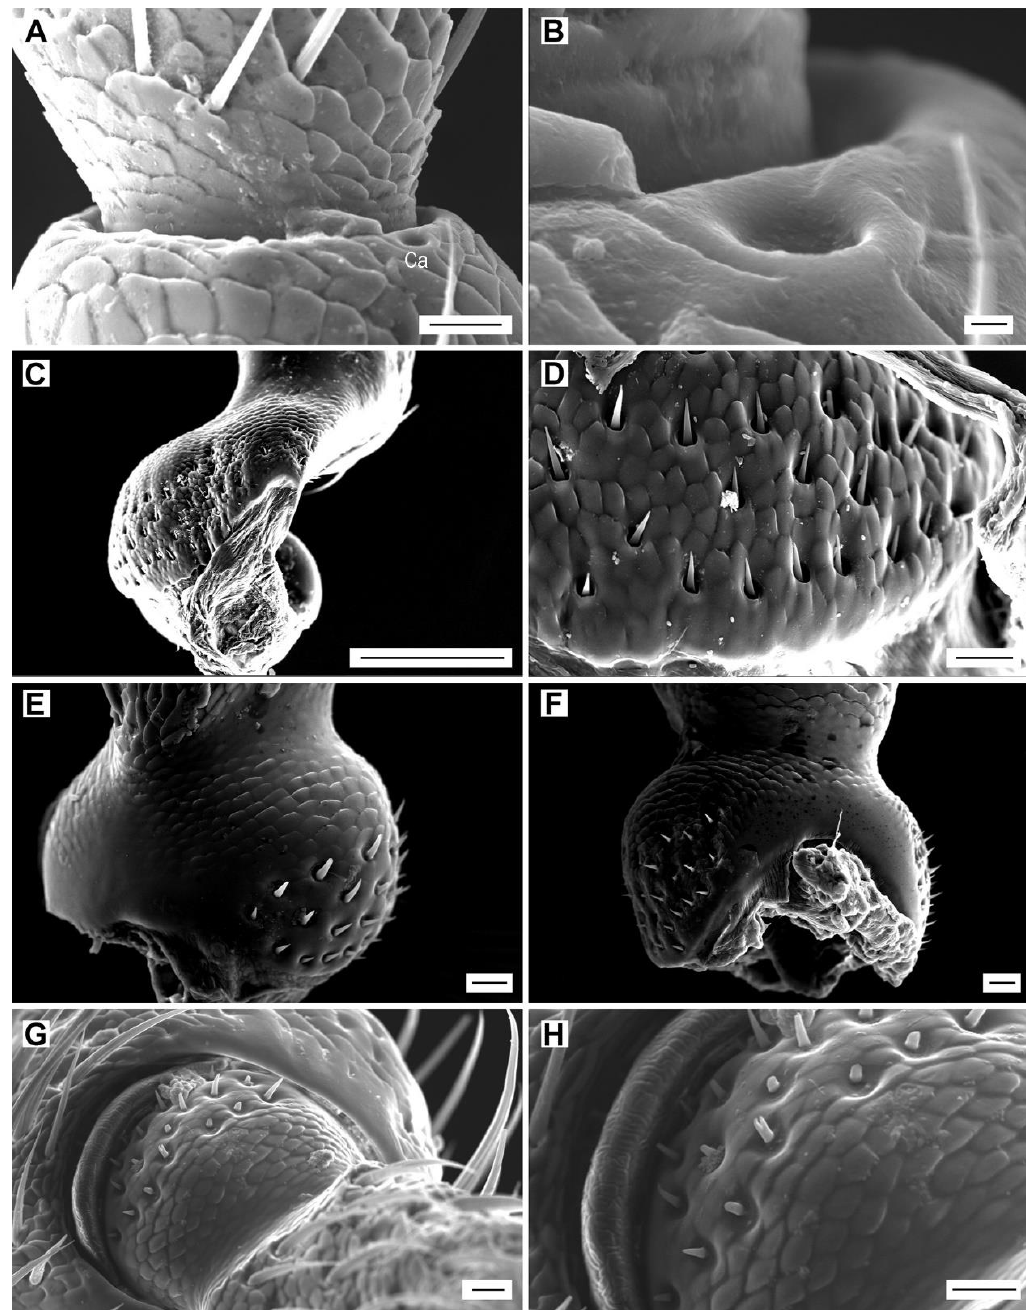
Figure 10. Sensilla campaniformia and Böhm sensilla. ( A ) A. acuminatus , male, location of campaniform sensillum (Ca) on the distal part of pedicel; ( B ) detail of campaniform sensillum; ( C ) A. modestus , male, Böhm sensilla on the scape; ( D ) detail of Böhm sensilla on the scape; ( E ) A. lineatus , male, Böhm sensilla on the pedicel, dorsally; ( F ) A. pilosellus , male, Böhm sensilla on the pedicel, ventrally; ( G ) A. obscurus , female, Böhm sensilla on the pedicel, dorsally ( H ) detail of the dorsal region of pedicel with Böhm sensilla. Scale bars = ( A , D – G ): 10 µ m; ( B ): 0.1 µ m; ( C ): 100 µ m; ( H ): not to scale.